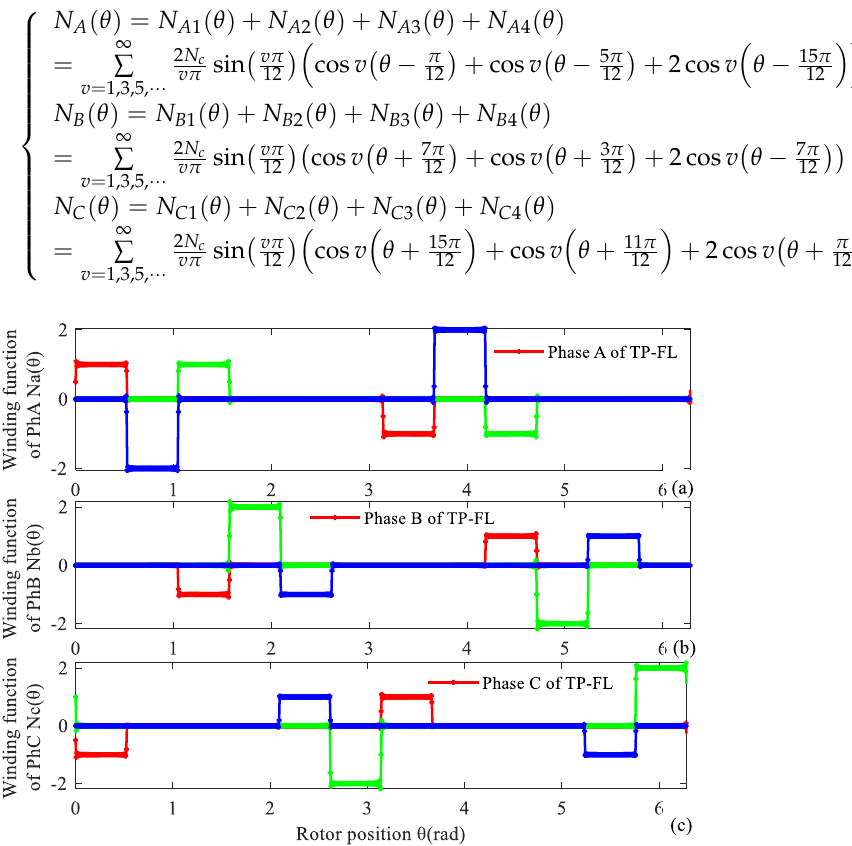
Figure 7. Winding function of TP-FL winding. ( a ) Phase A, ( b ) Phase B, ( c ) Phase C. Resultant winding MMF of a TP-FL winding can be considered as a combination of two groups of three-phase double-layer (TP-DL) winding. When time t equals 1.667 × 10 −3 s, the normalized values of phase current are equal to i A = 0.5 A, i B = 0.5 A, i C = −1 A. Resultant winding MMF curve of TP-FL winding is also validated by the FEM as shown in Figure 8.